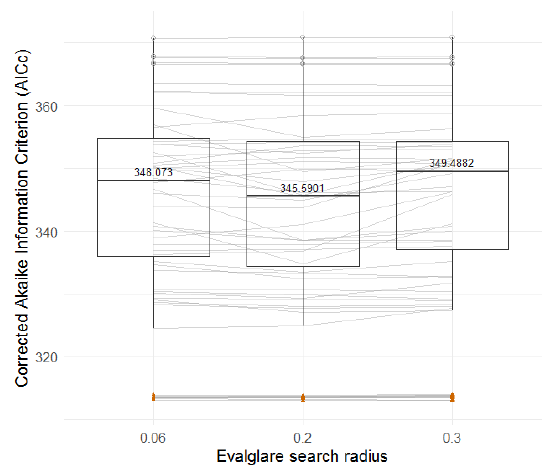
Figure 23. Boxplots of AICc for the three search radius (laboratory study).